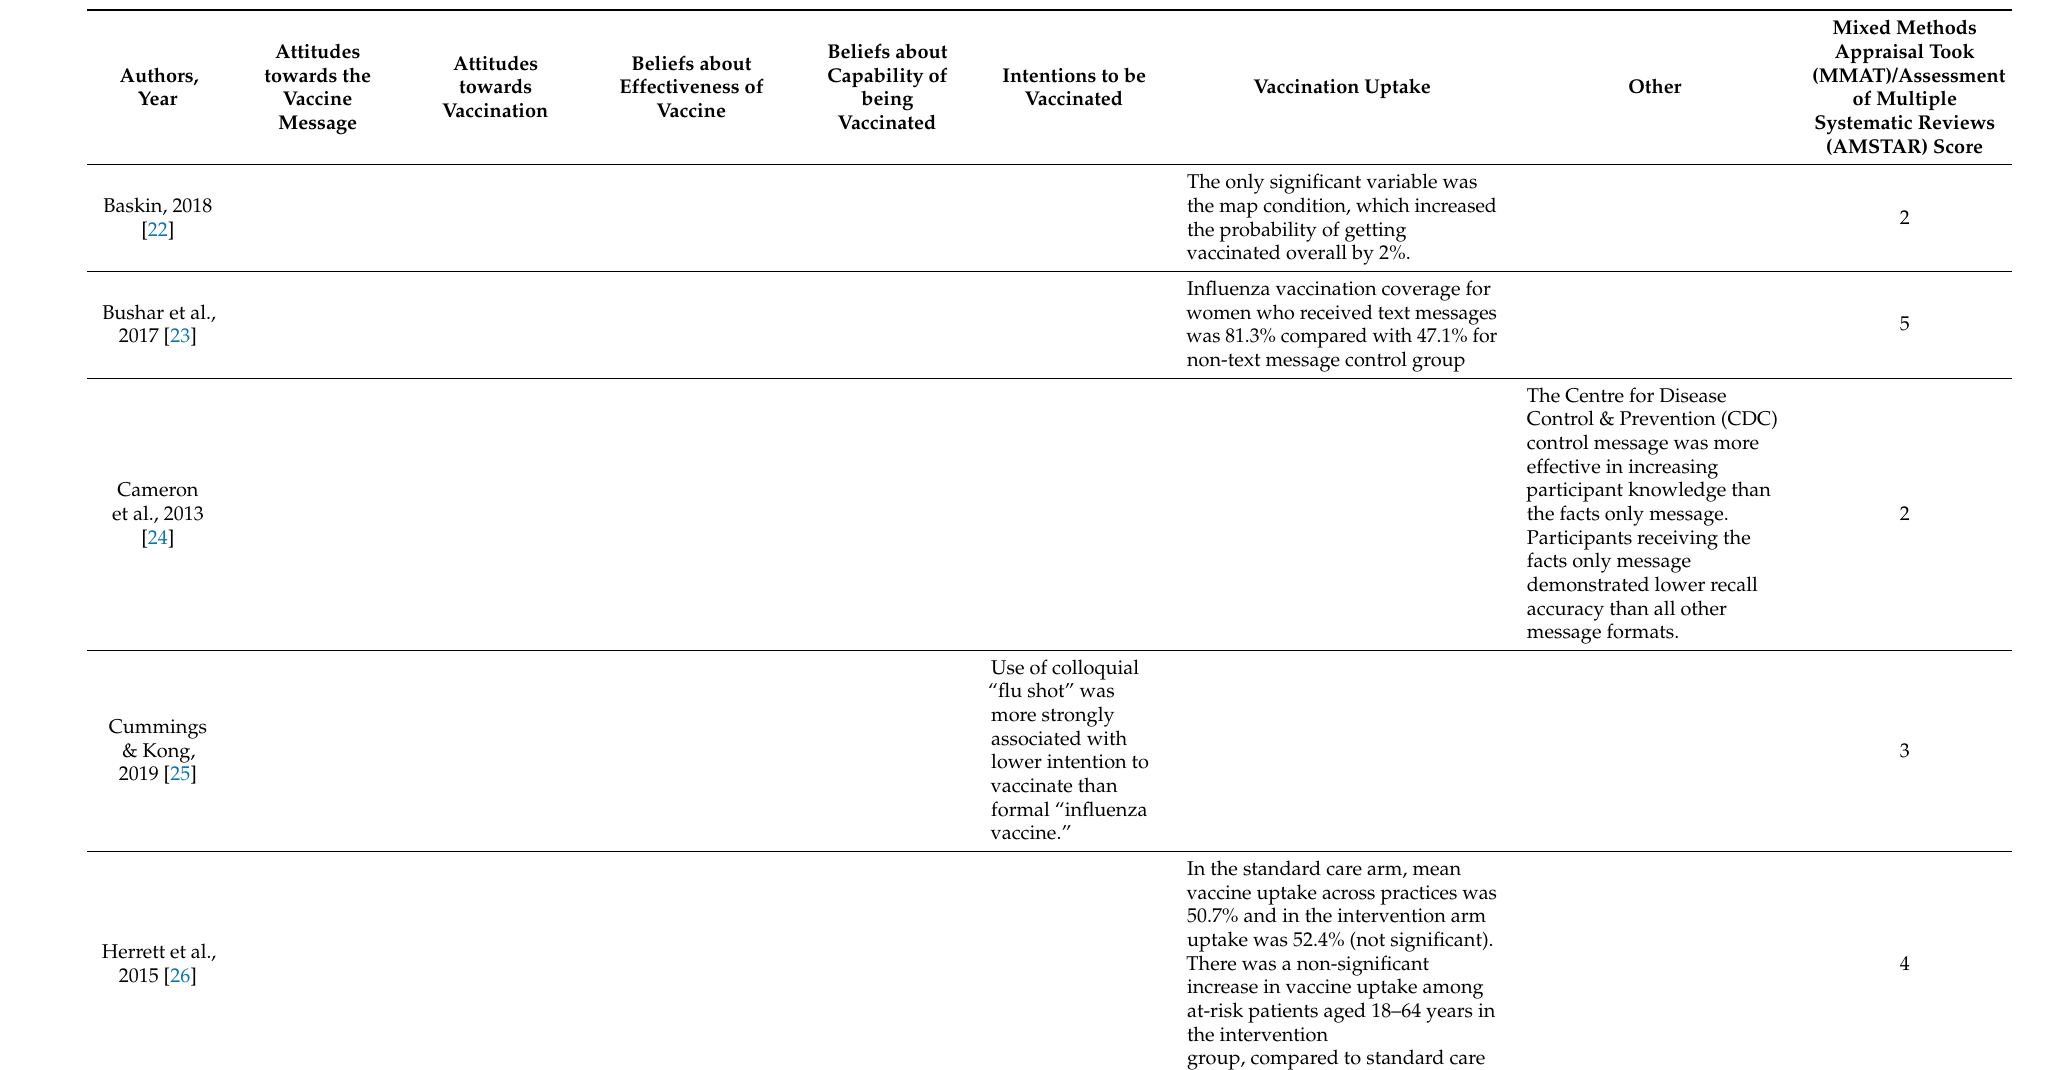
Table 1. Results of the included